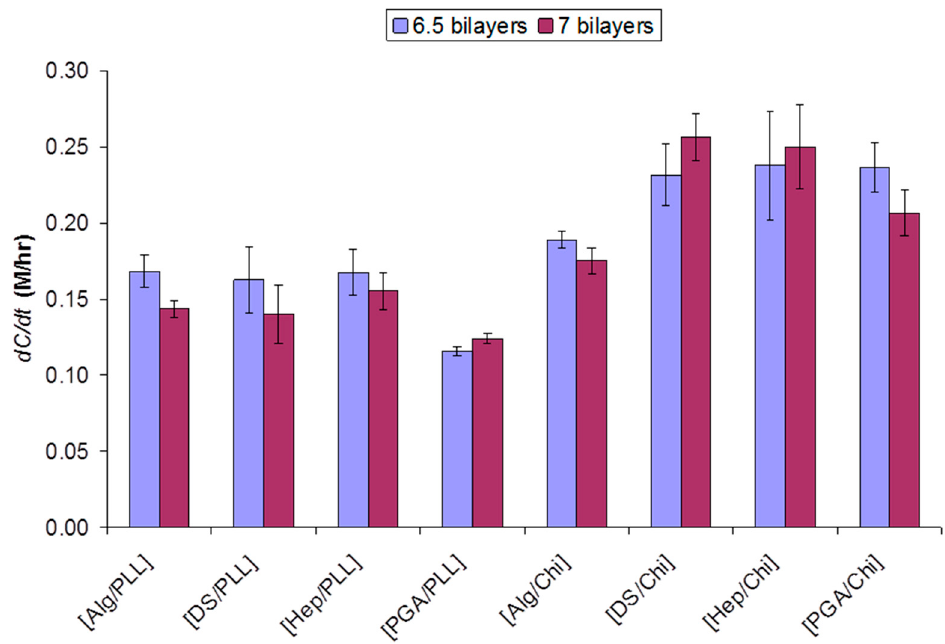
Figure 2. Permeate concentrations of glucose through the films were measured as a function of time ( dC / dt ). Error bars indicate 95% confidence intervals (n = 3).